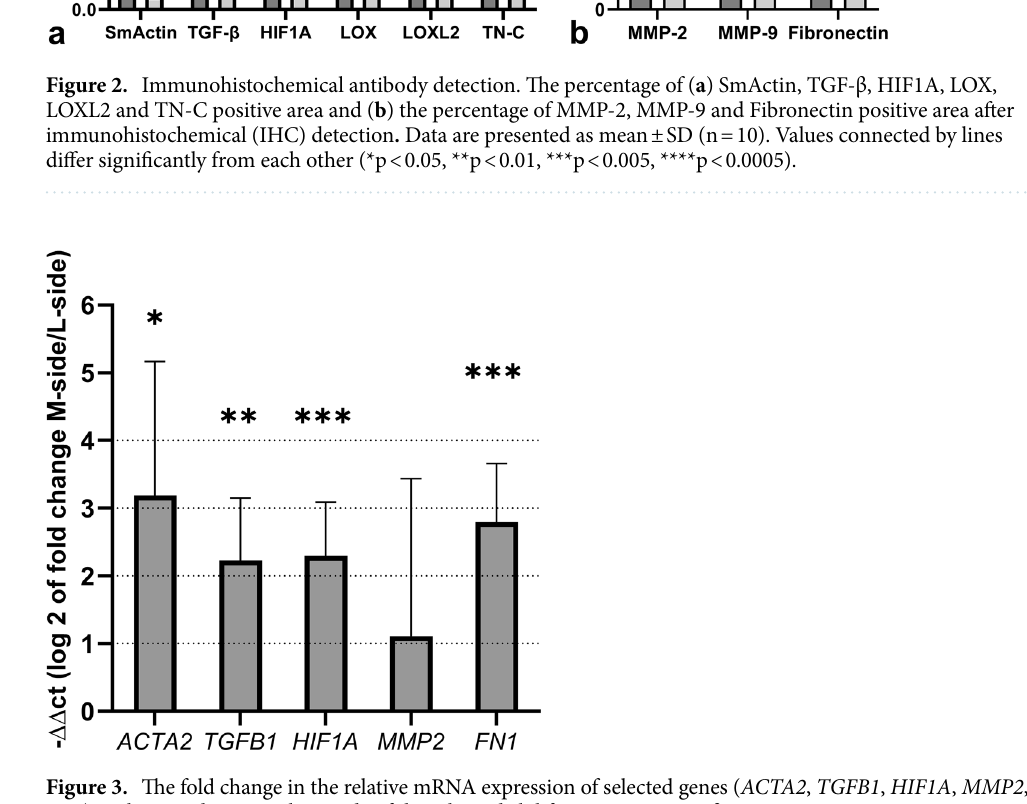
Figure 3. The fold change in the relative mRNA expression of selected genes ( ACTA2 , TGFB1 , HIF1A , MMP2 , FN1 ) in the M-side versus the L-side of the relapsed clubfoot tissue. A significant increase in expression was detected in the contracted medial side, in comparison with the non-contracted lateral side. The gene expression is normalized to the reference gene B2M and the mean expression value of the particular gene in the corresponding L-side tissue sample. Data are presented on a log scale as mean ± SD. The significance level is indicated as follows: *p < 0.05, **p < 0.01, ***p < 0.005.